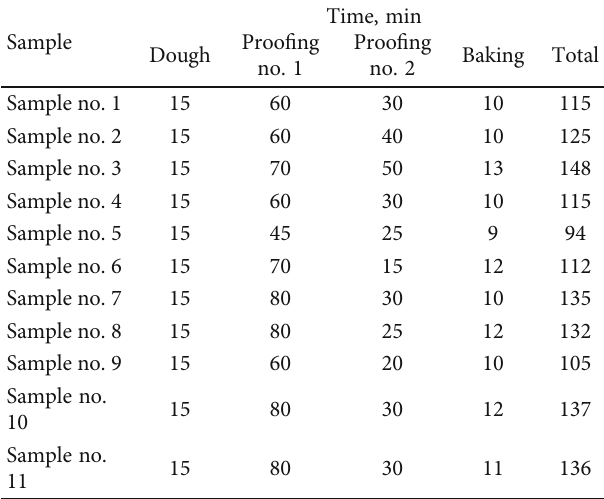
Table 3: Proo fi ng and baking times of the control sample and new assortments of buns.